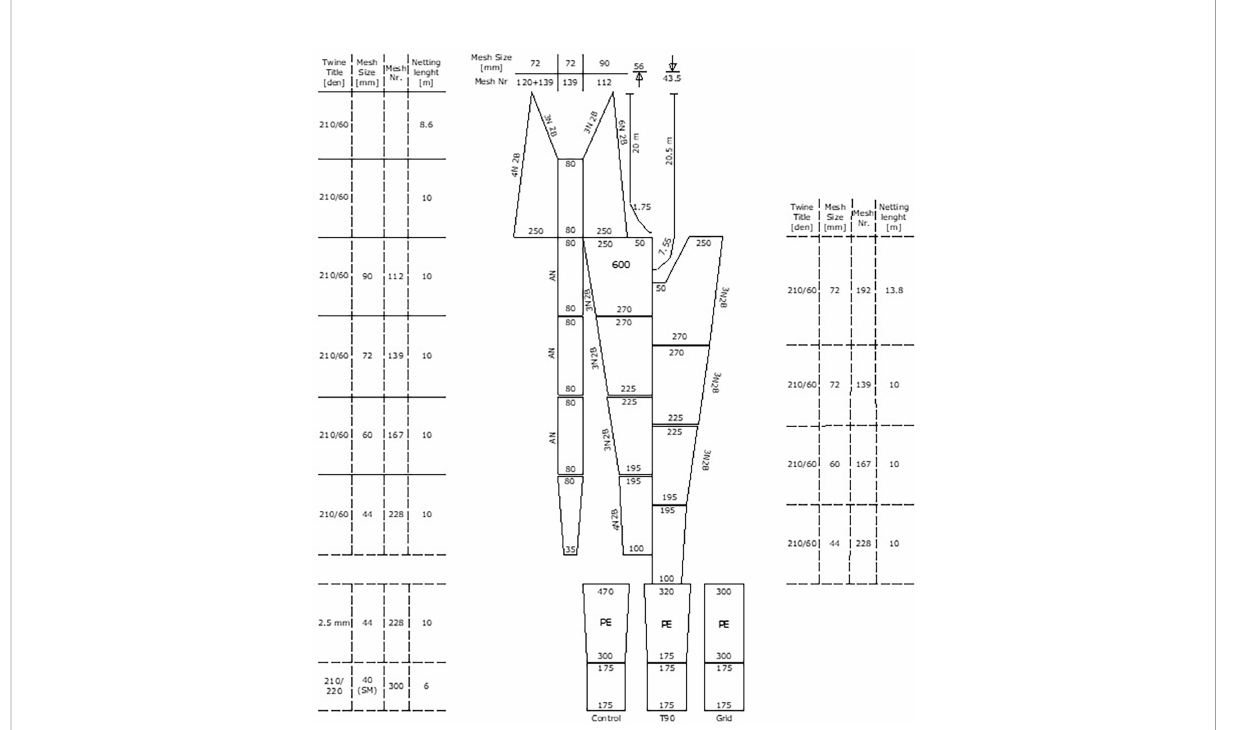
FIGURE 2 Scheme of the trawl nets used in the survey, with details of the extension piece of the three net con fi gurations (Control, Grid and